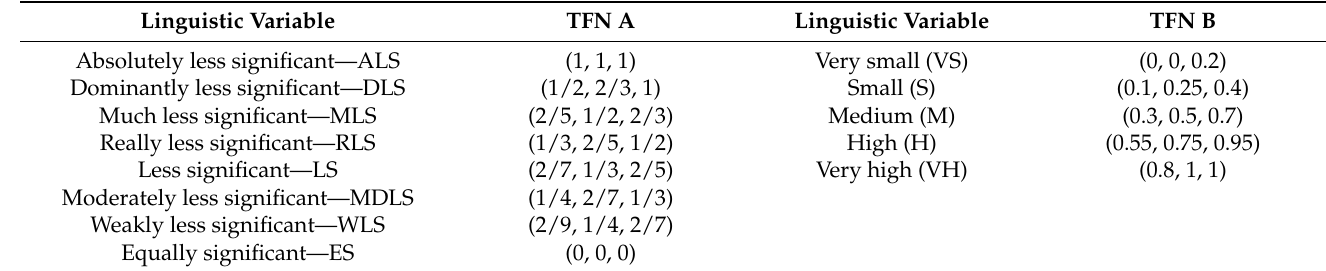
Table 1. Linguistics and the TFN